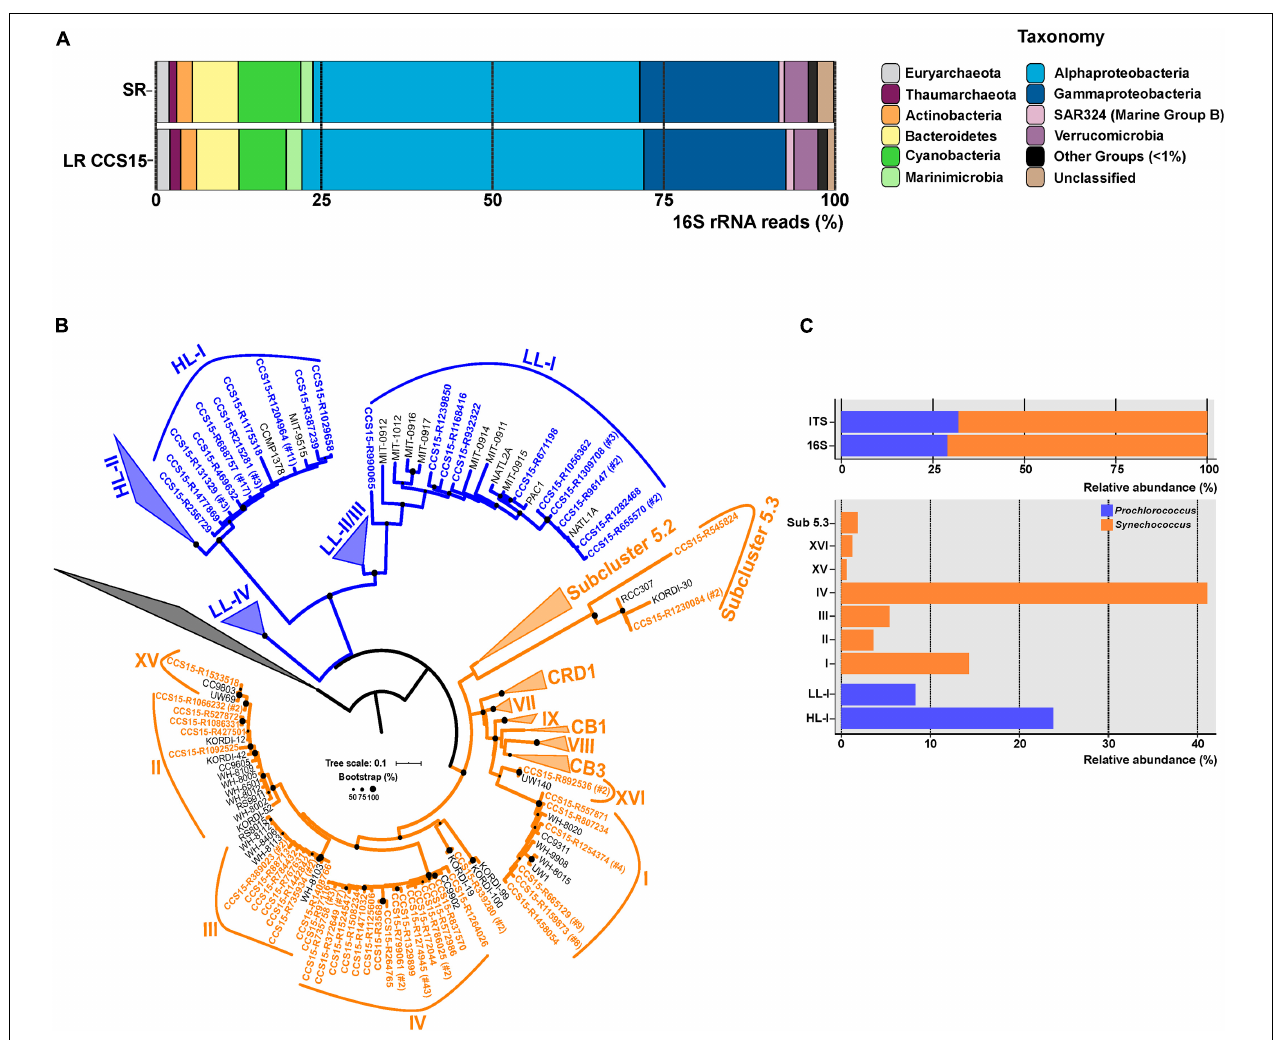
FIGURE 1 | (A) Phylum-level composition based on 16S rRNA gene fragments of Illumina (SR) and PacBio CCS15 metagenomic reads. The phylum Proteobacteria was divided into its class-level classification. Only those groups with abundance values larger than 1% are shown. (B) Maximum-likelihood phylogenetic tree of the 16S–23S rRNA genes ITS extracted from CCS15 reads classified by 16S rRNA as Cyanobacteria. Sequences are colored according to their affiliation to Prochlorococcus (blue) or Synechococcus (orange). In order to simplify the tree, nucleotide sequences were dereplicated at 99% identity. Numbers between brackets indicate the number of sequences that clustered at this level to a given CCS15 read (in bold). ITS from reference isolates are also shown (black). (C) Upper panel, relative abundance of Synechococcus and Prochlorococcus identified from ITS or 16S rRNA sequences in the CCS15 reads. Bottom panel, ITS classified into subclades and